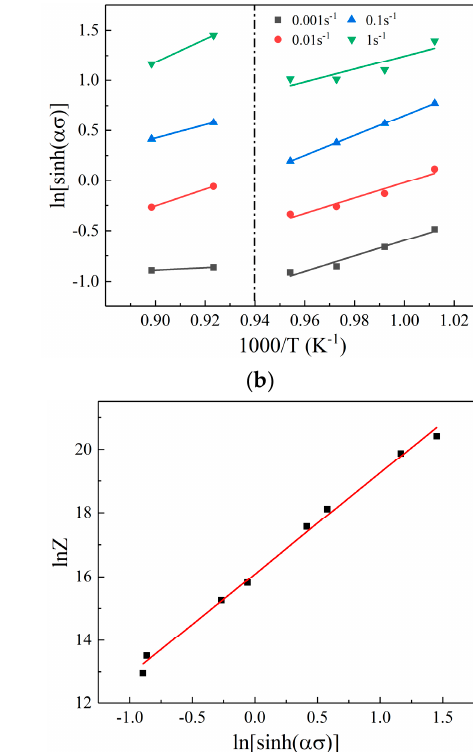
Table 2. Constitutive model parameters for Ti-6554 alloy.